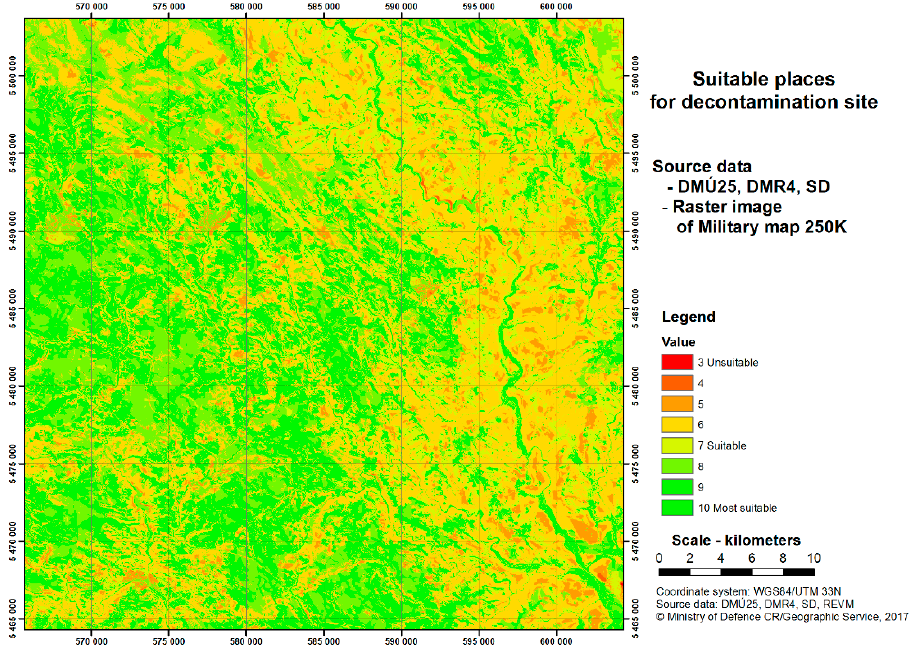
Figure 8. Cost map for an evaluation of suitable places for the deployment of the decontamination site from data of DMU25, DMR4, and SD.